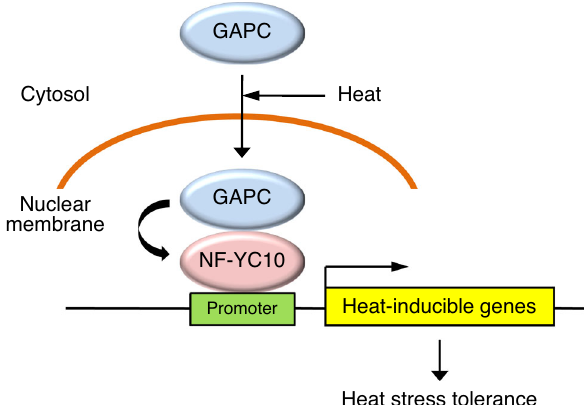
Fig. 10 Proposed model for GAPC-mediated heat response in Arabidopsis. GAPC that normally exists in the cytosol enters the nucleus in response to heat. In the nucleus GAPC binds to the transcription factor NF- YC10 to increase the expression of heat-inducible genes, rendering Arabidopsis tolerant to heat